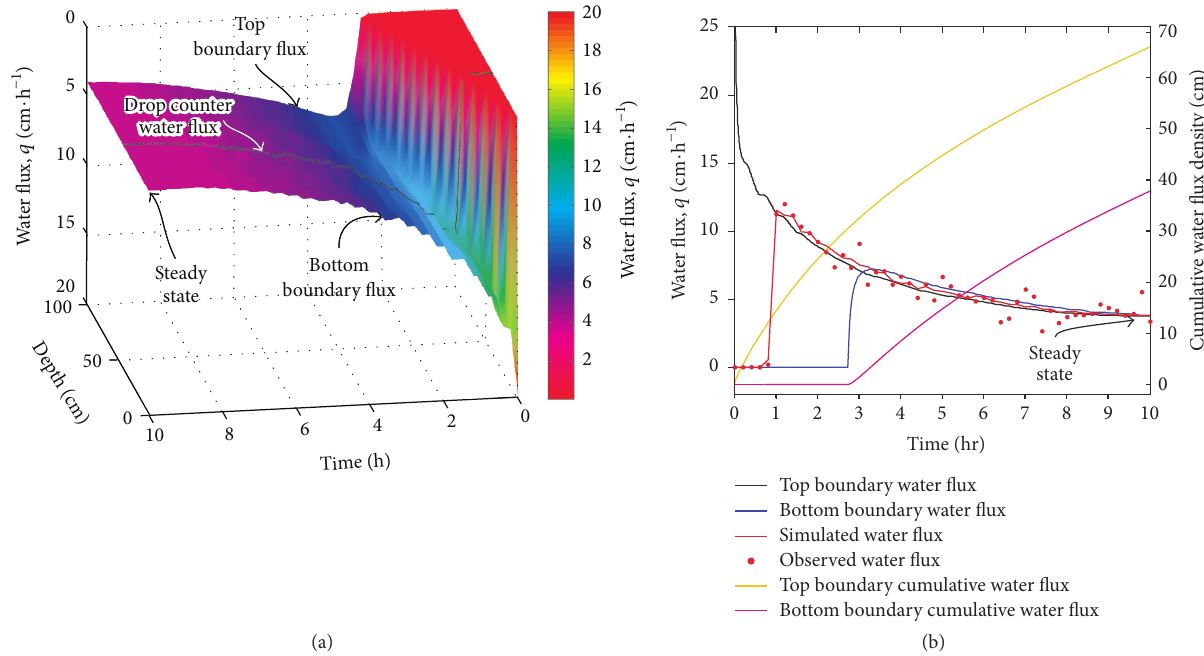
Figure 9: Water flux, 𝑞 , in a transient state as a function of depth and time: (a) water flux simulated in a 3D plot showing upper boundary flow ( 𝑧 = 0 cm), lower boundary flow ( 𝑧 = 100cm), and water flux at bottom of the drop counter ( 𝑧 = 60 cm); (b) the same curves as in (a) (left axis) and the cumulative water flux measured in the drop counter and simulated by Hydrus-1D (right